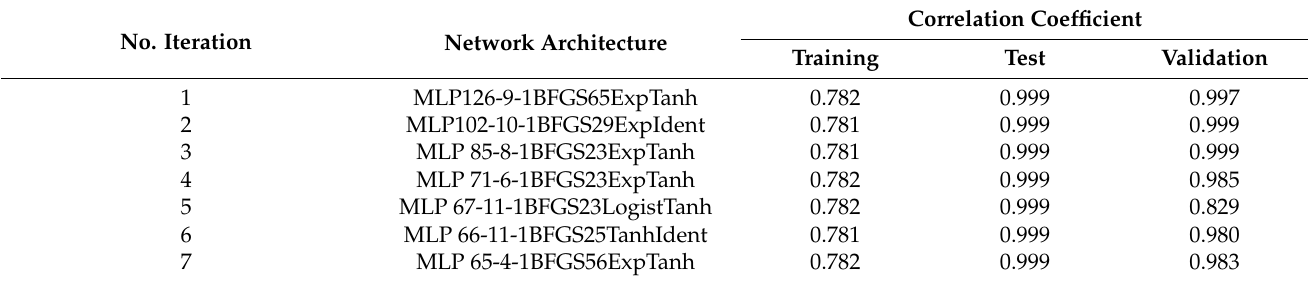
Table 2. Neural networks were obtained after iterative modeling.